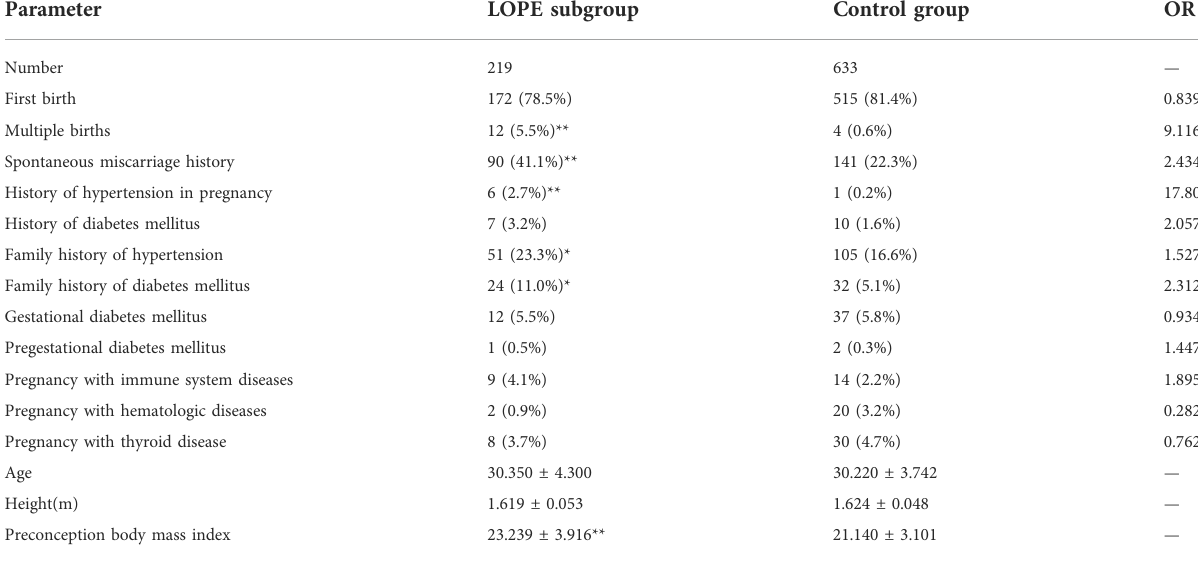
TABLE 3 Analysis of factors that do not change with gestational age in LOPE subgroup and control group.